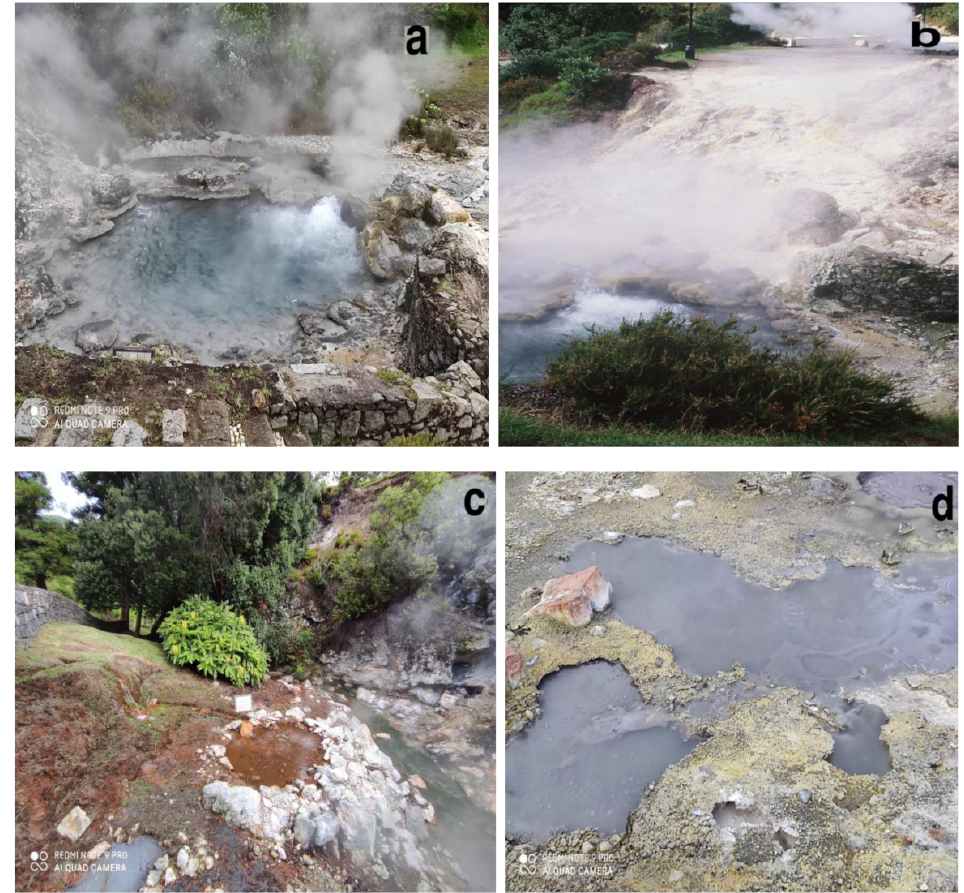
Figure 2. Caldeiras-Furnas village: ( a ) boiling fumaroles with steam explosions and steam heated pools; ( b ) interaction between fumarolic acid plume and the ground surface; ( c ) acid-sulfate rocks supported changes of colours from white to yellowish and red colour caused by precipitation of FeO(OH) after the Fe 2+ oxidation, where jarosite precipitated. Lagoa das Furnas: ( d ) Fumarole activity and steaming grounds are well spread around the Furnas